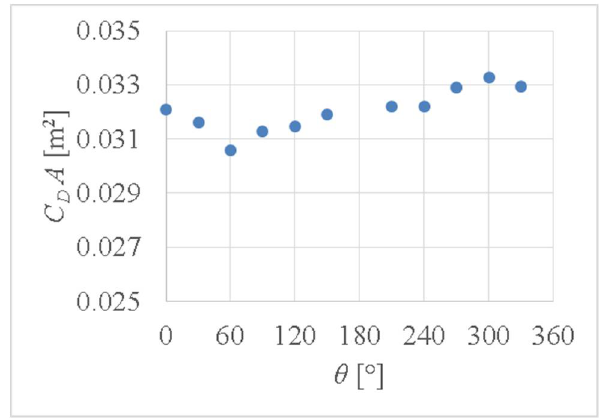
Figure 8. C D A vs. phase difference at 14